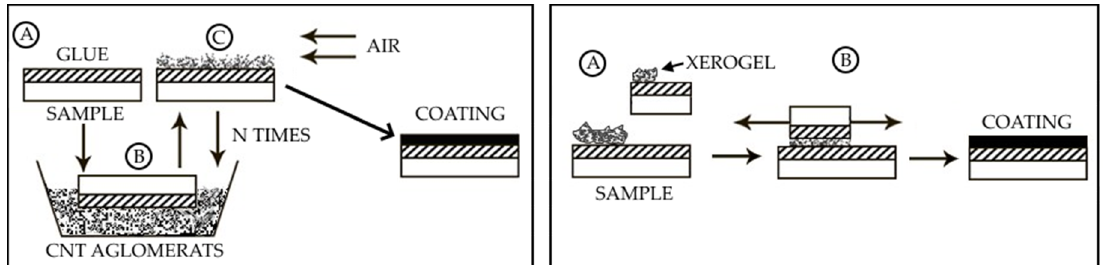
Figure 1. Two application methods: on the left is the method of dipping the sample into agglomerates (Stage A—applying the adhesive layer to the surface, B—dipping the sample into agglomerates, C— blowing off non-fixed CNTs), on the right is the xerogel grinding method (Stage A—applying xerogel powder to the prepared sample, stage B—grinding the powder until a homogeneous layer is formed).